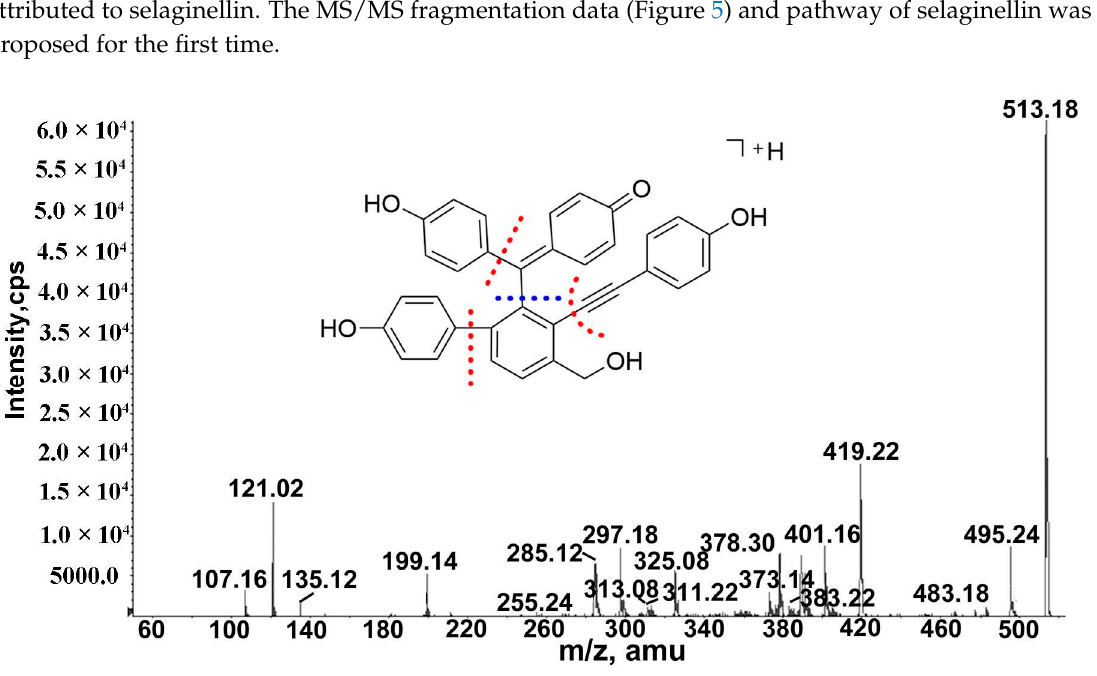
Figure 5. MS n spectrum of selaginellin.